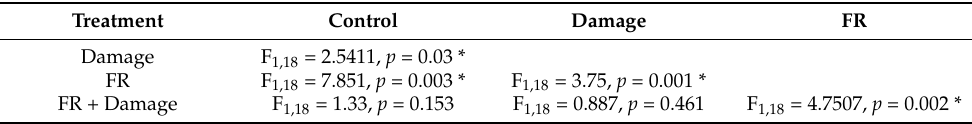
Table 2. Non-volatile secondary metabolite composition as a function of light quality and herbivore damage. Pairwise (post hoc) comparison of the non-volatile secondary metabolite composition Solidago altissima plants that had been exposed to control light (Control), or control light supplemented with FR light (FR), while being undamaged or damaged by two larvae of S. frugiperda in L3 instar (Damage). Treatment Control Damage